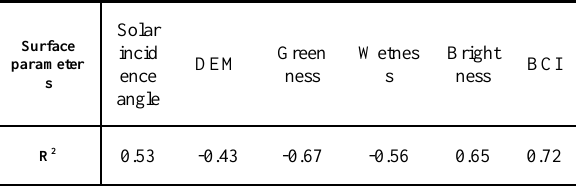
Table 1. Relationship between the PC1 of LST and the PC1 of